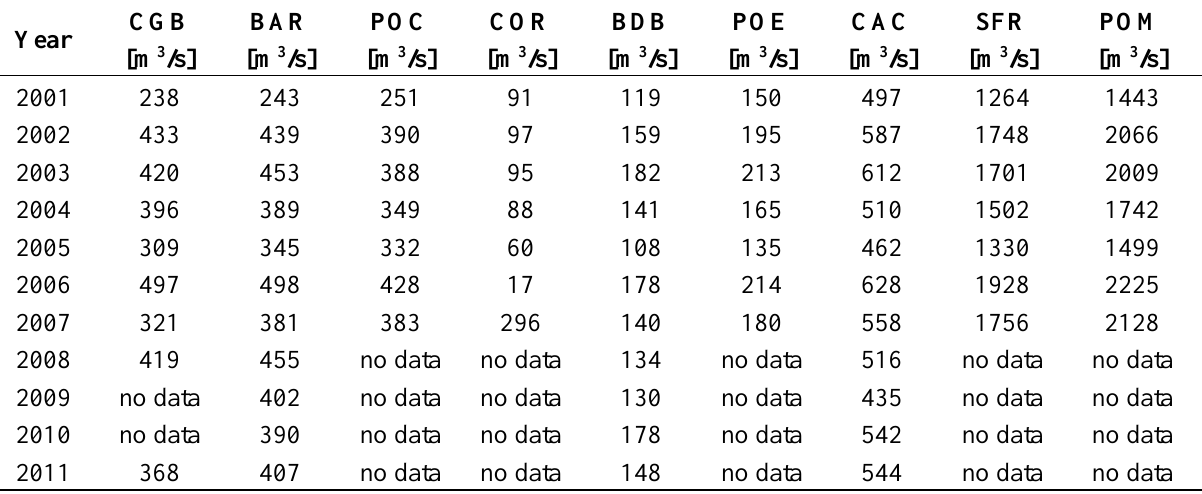
POM—Porto da Manga) for the years 2001 to